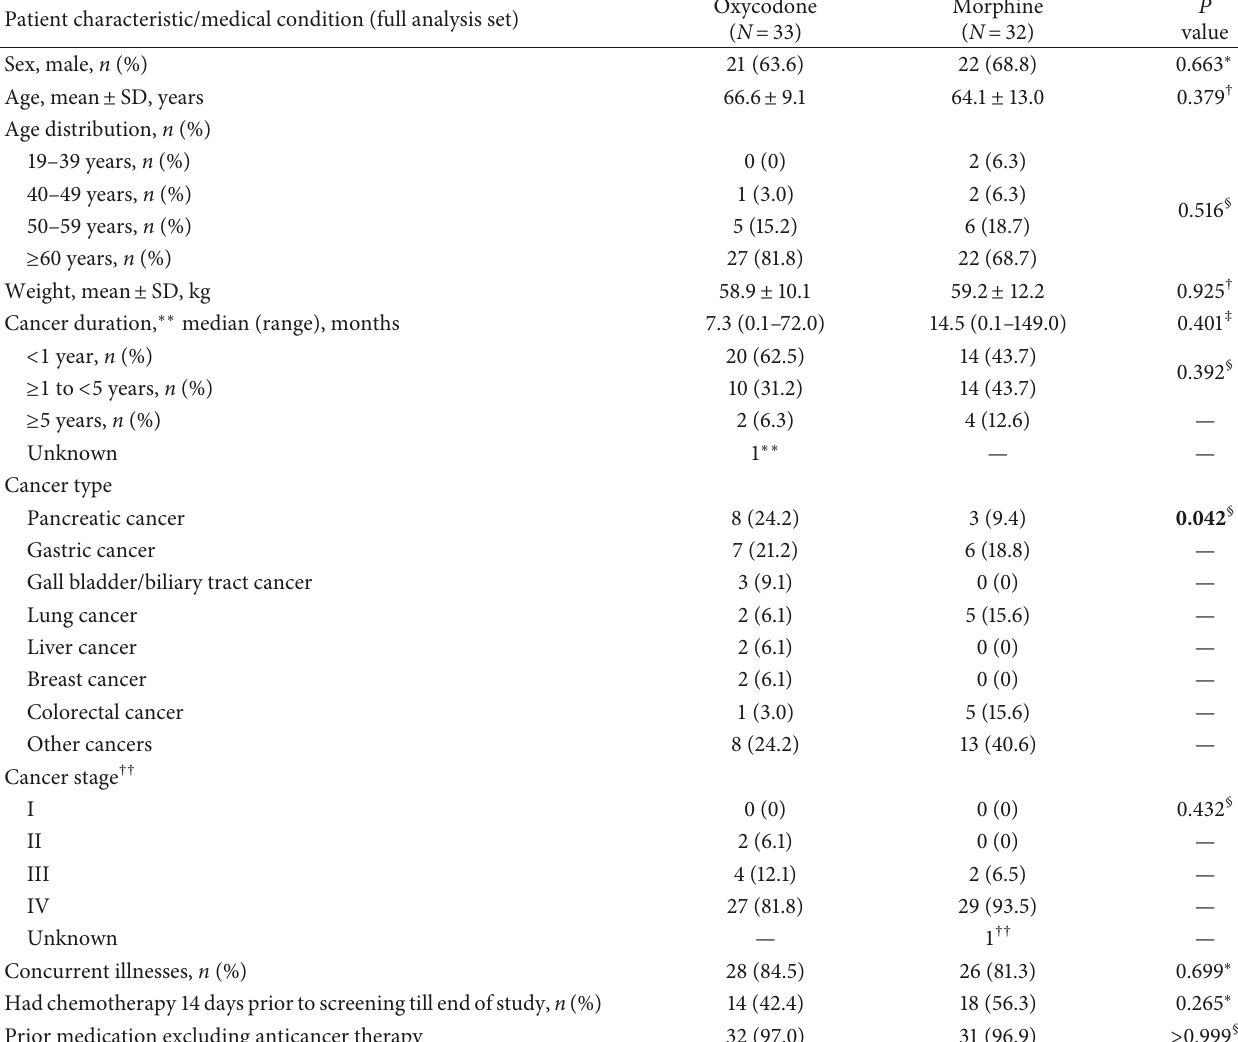
Table 1: Patient characteristics and medical